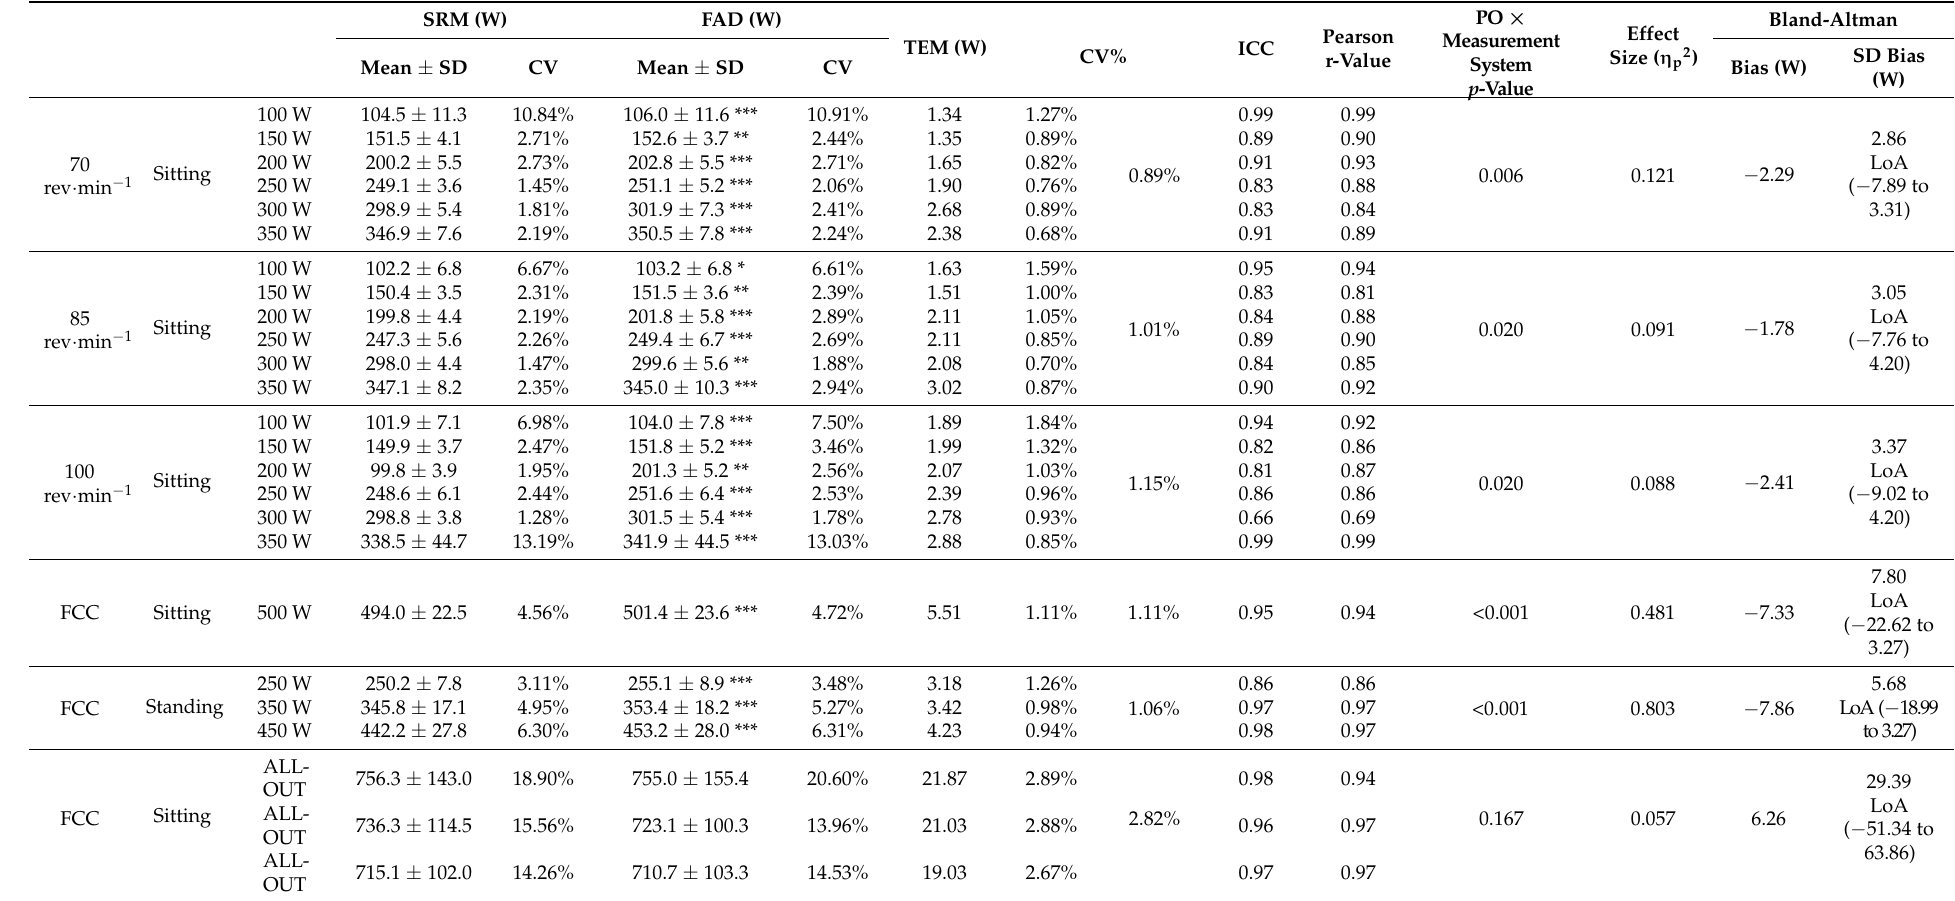
Table 1. Analysis of the mean power output (PO) registered by the SRM and the FAD power